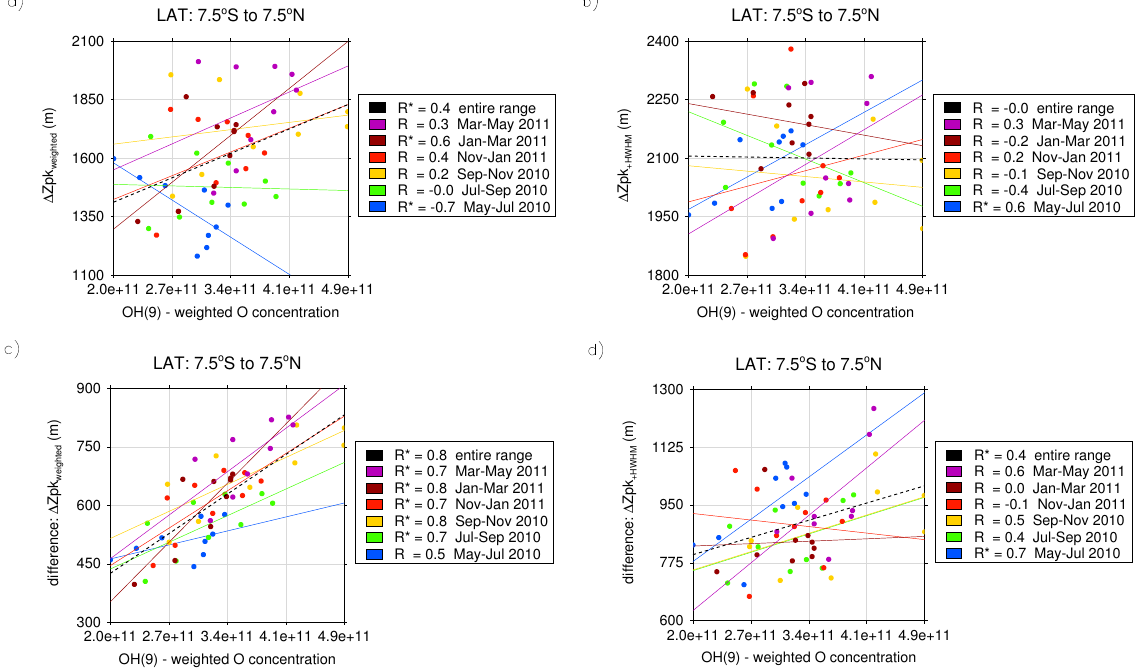
Fig. 9: Correlation plots of vertical OH(9;5) profile shifts (left panels Eq.3, right panels Eq.4) vs. OH(9) profile weighted O concentrations. The upper panels show the correlation between OH(9;5) profile shifts and O concentrations for the full quenching model run (similar to Fig. 7a). Similar to Fig. 7c, the lower panels consider the difference in vertical OH(9;5) profile shifts between the full quenching and the deactivated O quenching model runs. Correlation coefficients are shown in the legend and denoted with the asterisk symbol *, if they were found to be significant according to a 90% significance level.